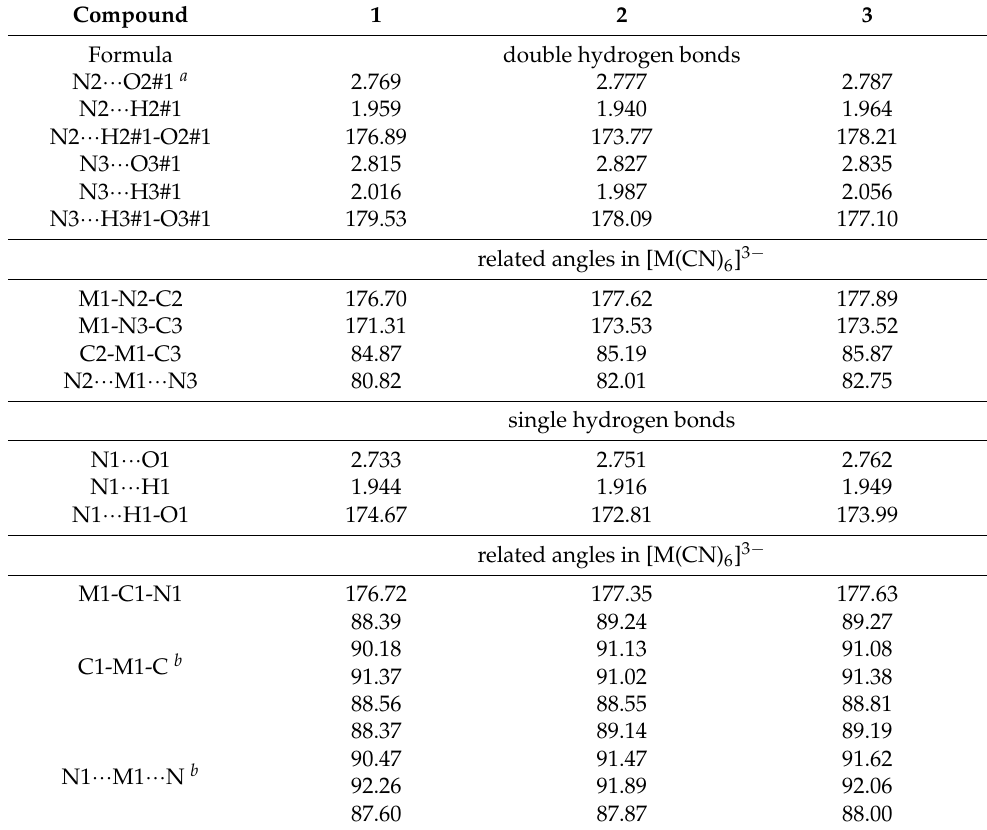
Table 1. The most important hydrogen-bonding parameters and related angles in 1 – 3 (in [Å] or in [deg]; see also Figure